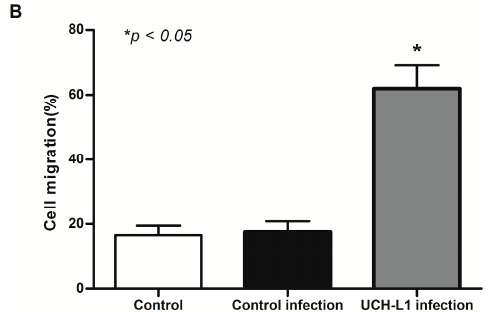
Figure 6. UCH-L1 overexpression induced podocyte hypermotility as assessed by cell migration assay. ( A ) Differentiated podocytes were infected with UCH-L1 overexpression adenoviral vector. Control cells were treated with vehicle vector or were not treated. Then subsequently scratch was processed using a 0.1 mL pipette. The observation was made immediately after scratch (0:00 h) and at 24:00 h, Original magnification, ×200; ( B ) quantification of the cell migration area by computerized morphometric analysis. Data are given as means + SD. n = 20 areas from three independent experiments. * p < 0.05 versus control group and control infection group, respectively.